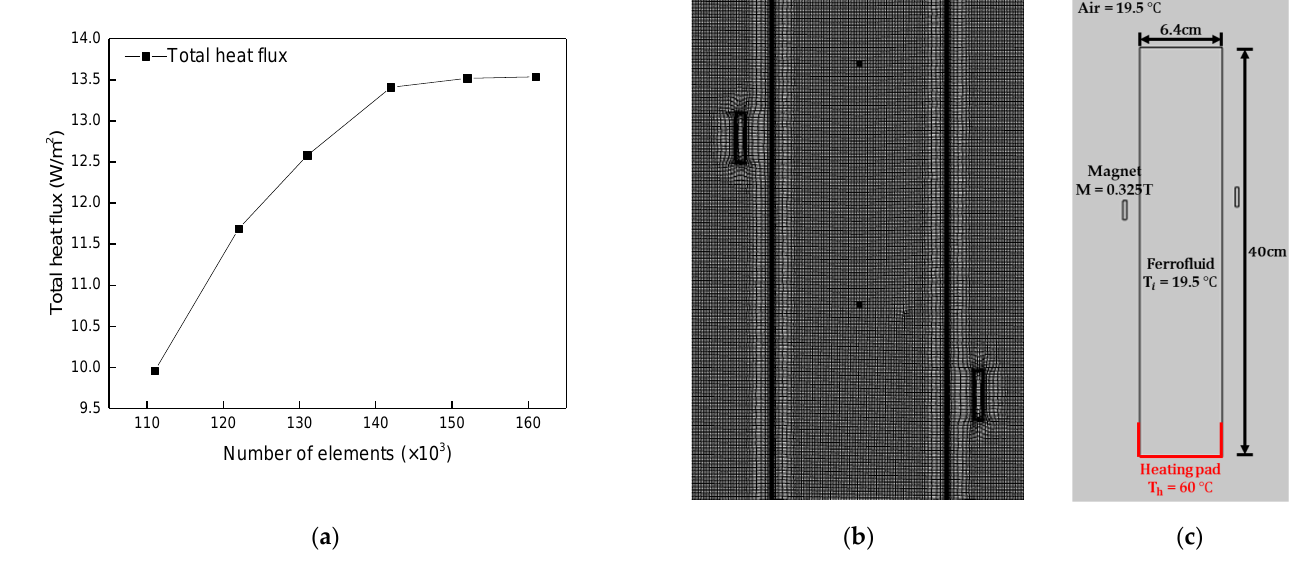
Figure 3. ( a ) Grid dependency test, ( b ) mesh configurations, ( c ) boundary conditions.